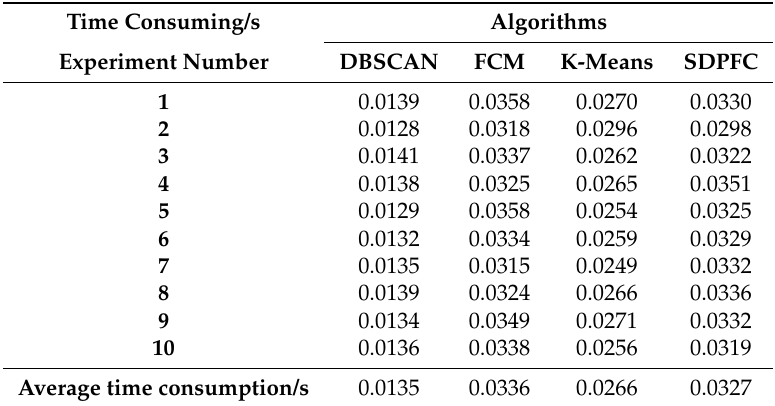
Table 1. Time-consuming table for each algorithm.